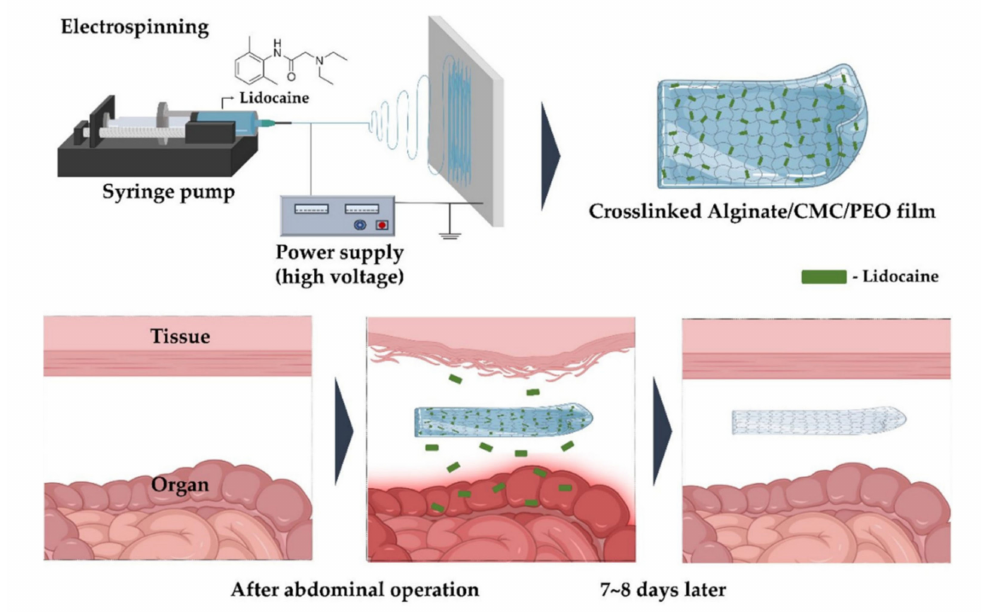
Figure 7. Fabrication of nanofibrous films by electrospinning